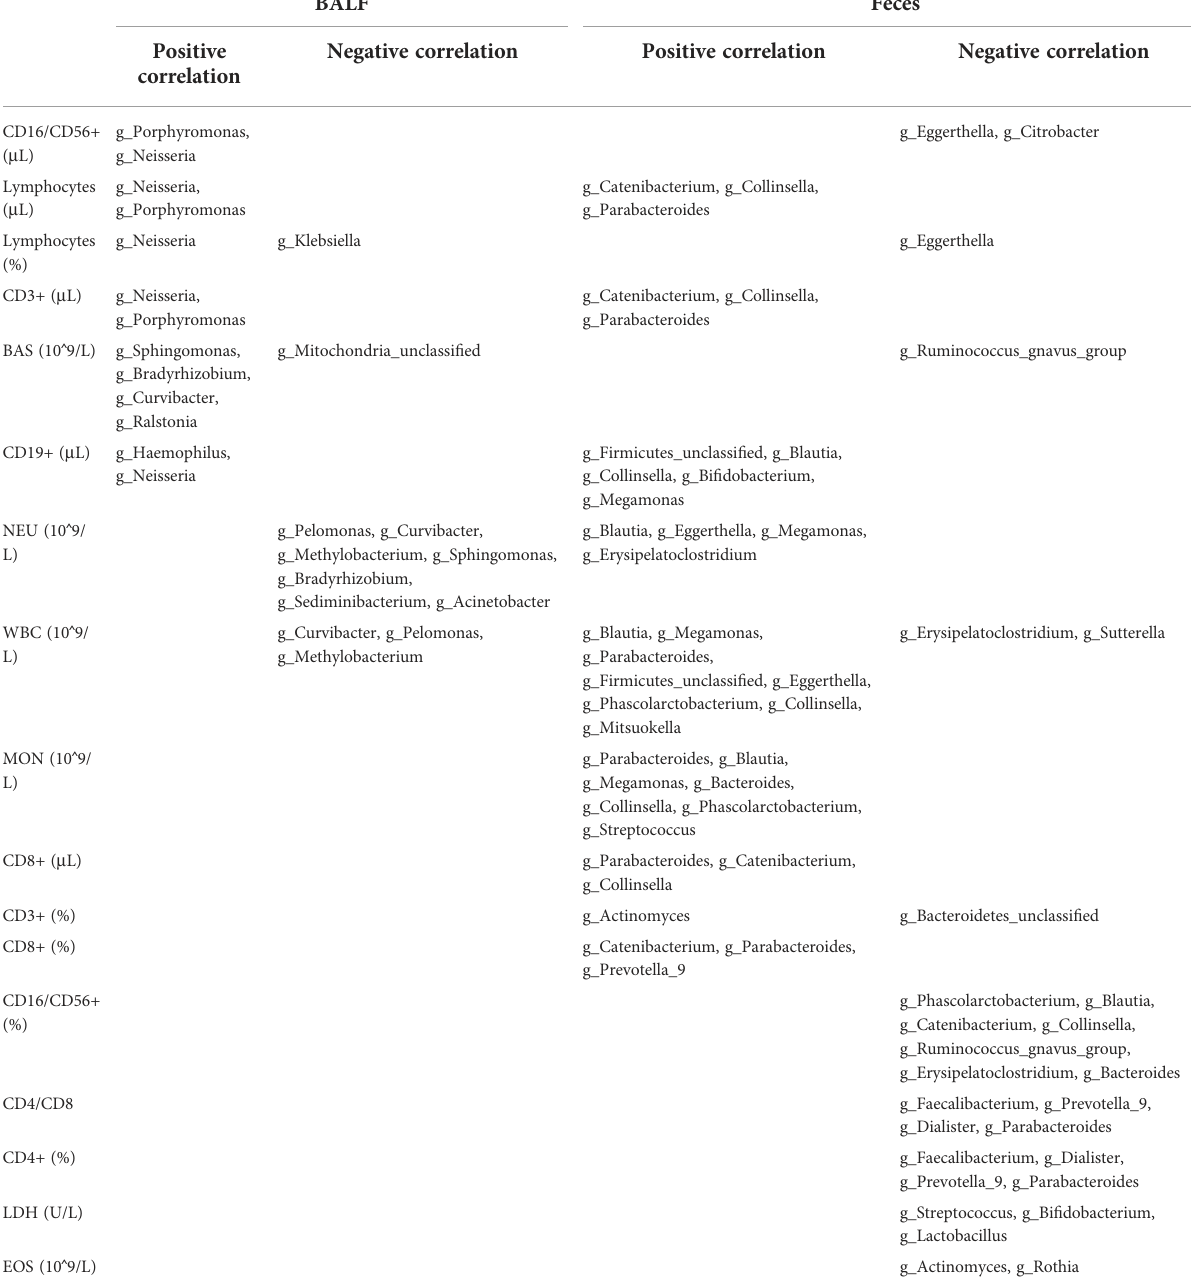
TABLE 1 Correlations between clinical indicators and intestinal or pulmonary microbiota. BALF Feces Positive Negative correlation Positive correlation Negative correlation